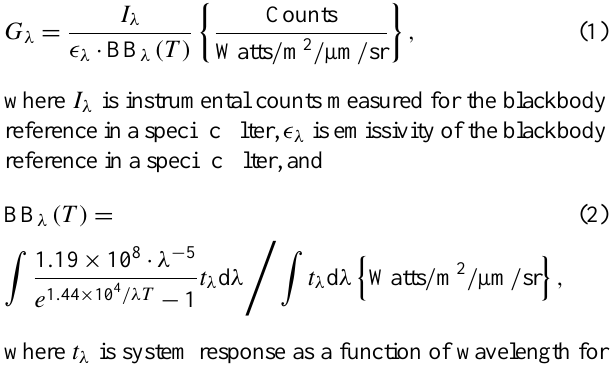
Fig. 3. Simulated clear-sky downwelling radiance for 22mm PWV Figure 3. Simulated clear-sky downwelling radiance for 22 mm PWV pointed at the zenith. 2 pointed at the zenith. Spectral response of two ASIVA filters (red Spectral response of two ASIVA filters (red and blue) used in this research. 3 and blue) used in this